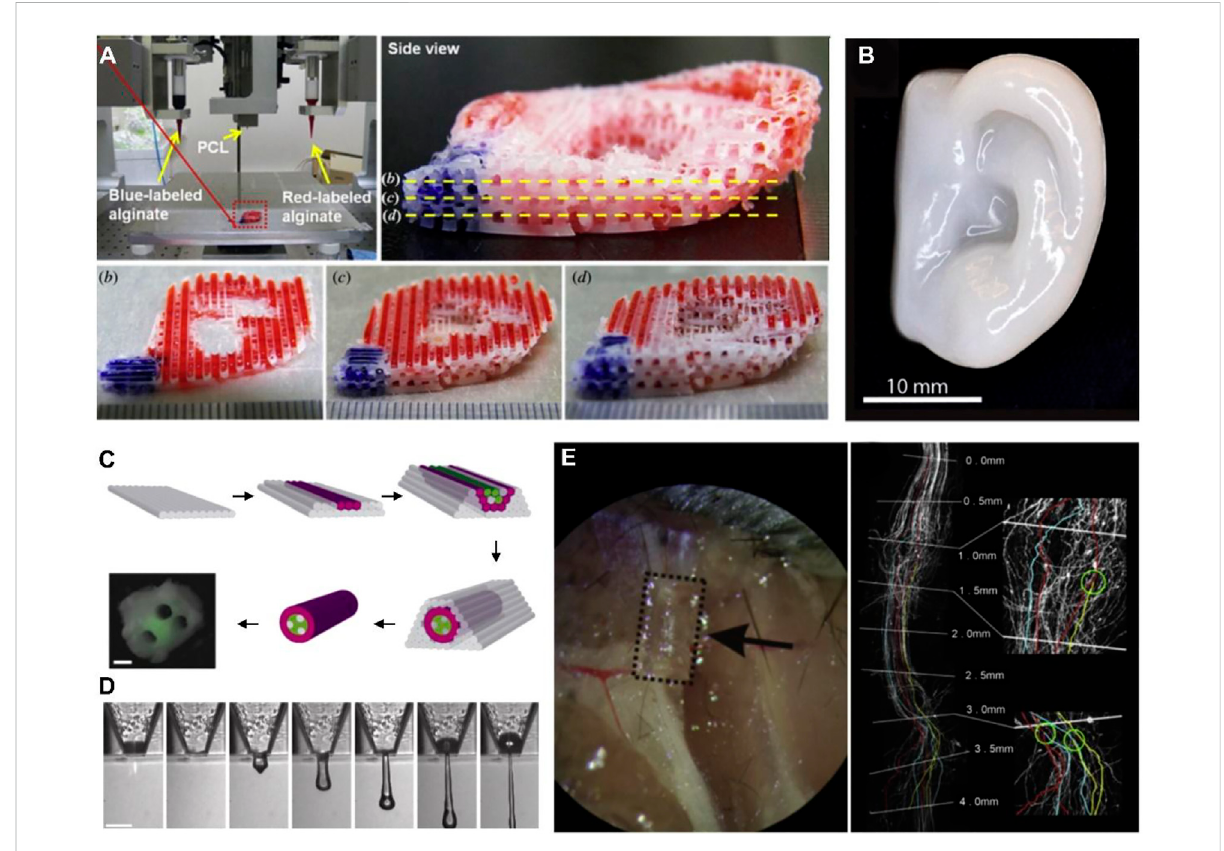
FIGURE 7 3Dioprintedtissues andorganswith celladhesion. (A) Printed ear-shaped PCLandalginatescaffolds (B) Cartilaginousearscaffolds printedwith humanchondrocytes (C) Fabricationofasyntheticnervegraftbyprinting SchwanncellsandBSMC (D) 3Dprintingmouseganglionandglialcells. (E) Printed PEG-based guidance conduits for nerve repair. Reproduced with permission from ref (Liu et al.,